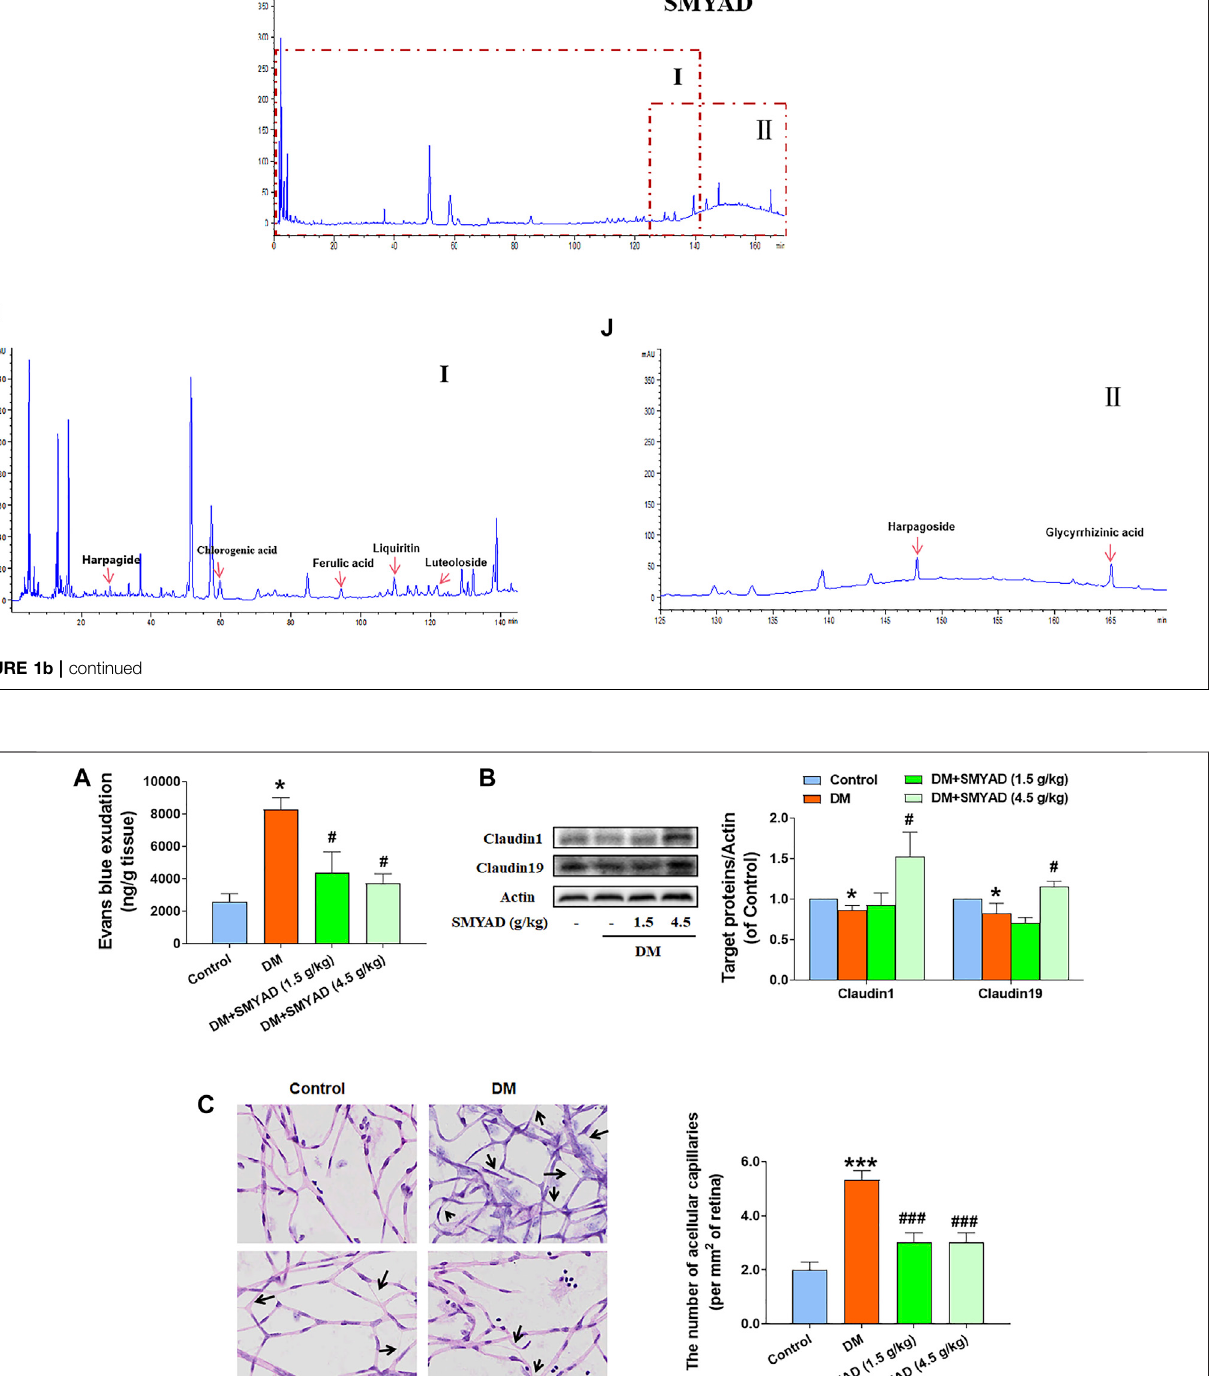
Frontiers in Pharmacology |